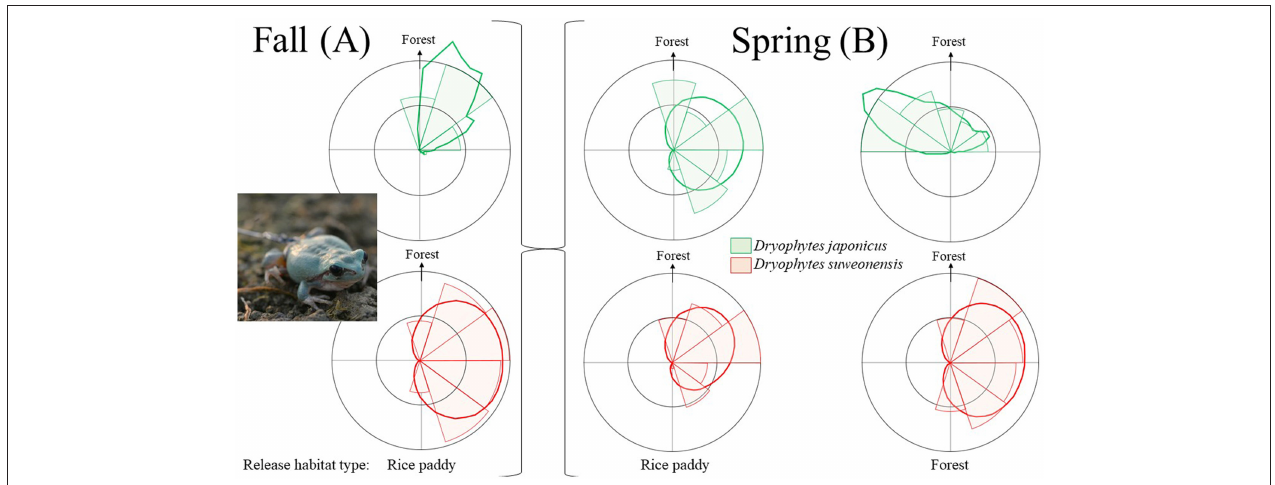
FIGURE 4 | Orientation of the paths taken by Dryophytes japonicus individuals (green) and D. suweonensis individuals (red) during the fall tracking experiment (A) corrected for release point for each individual. Dryophytes japonicus individuals were directed toward forests in 66.2% of cases, and D. suweonensis individuals moved toward rice paddies in 41.14% of cases and toward forests in 16.4% of cases. Rose diagrams show variation in the angles of displacement between Dryophytes japonicus and D. suweonensis in relation to the release habitats (rice paddies or forest; B ). The differences in the angles of displacement are significantly different between the two types of environments for both species. The dark lines are kernel density estimates representative of the weighted relative directionality to forest, and the light shaded areas are abundances proportional to radius. For the analyses, direction to forest was used as 0 degrees, and is thus indicated at the top of each rose diagram.